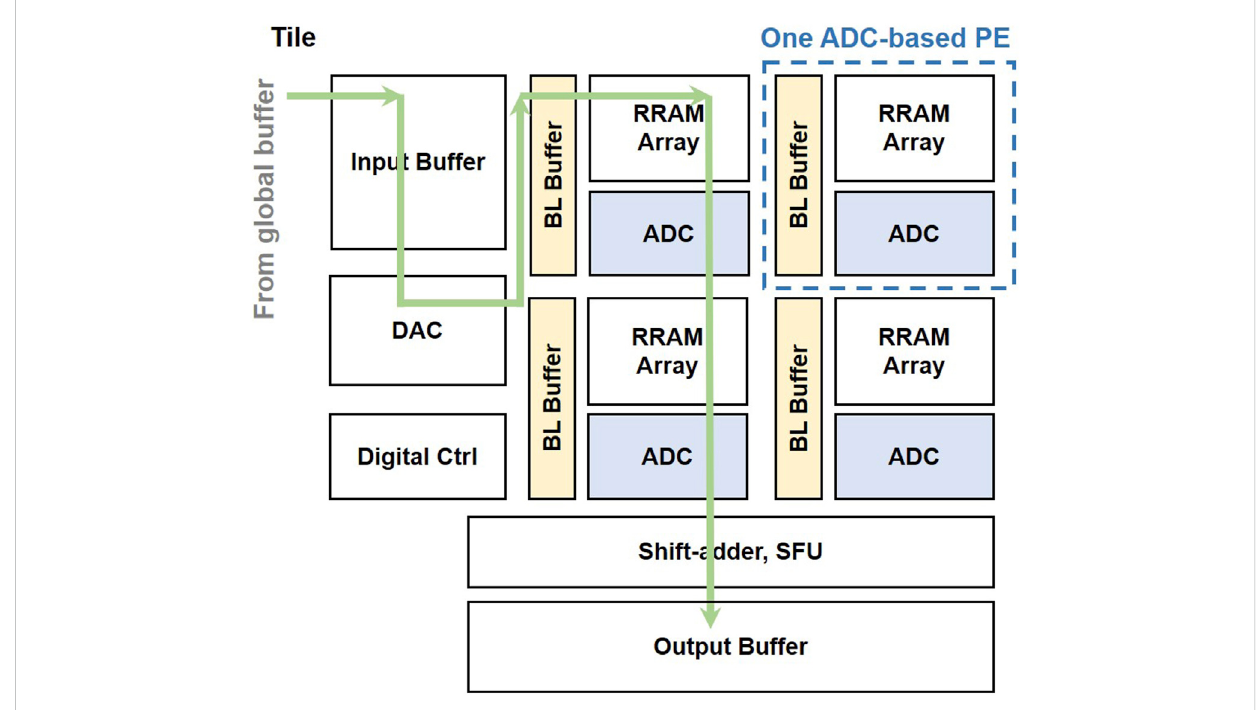
FIGURE 7 Baseline design with conventional ADC-based PE.